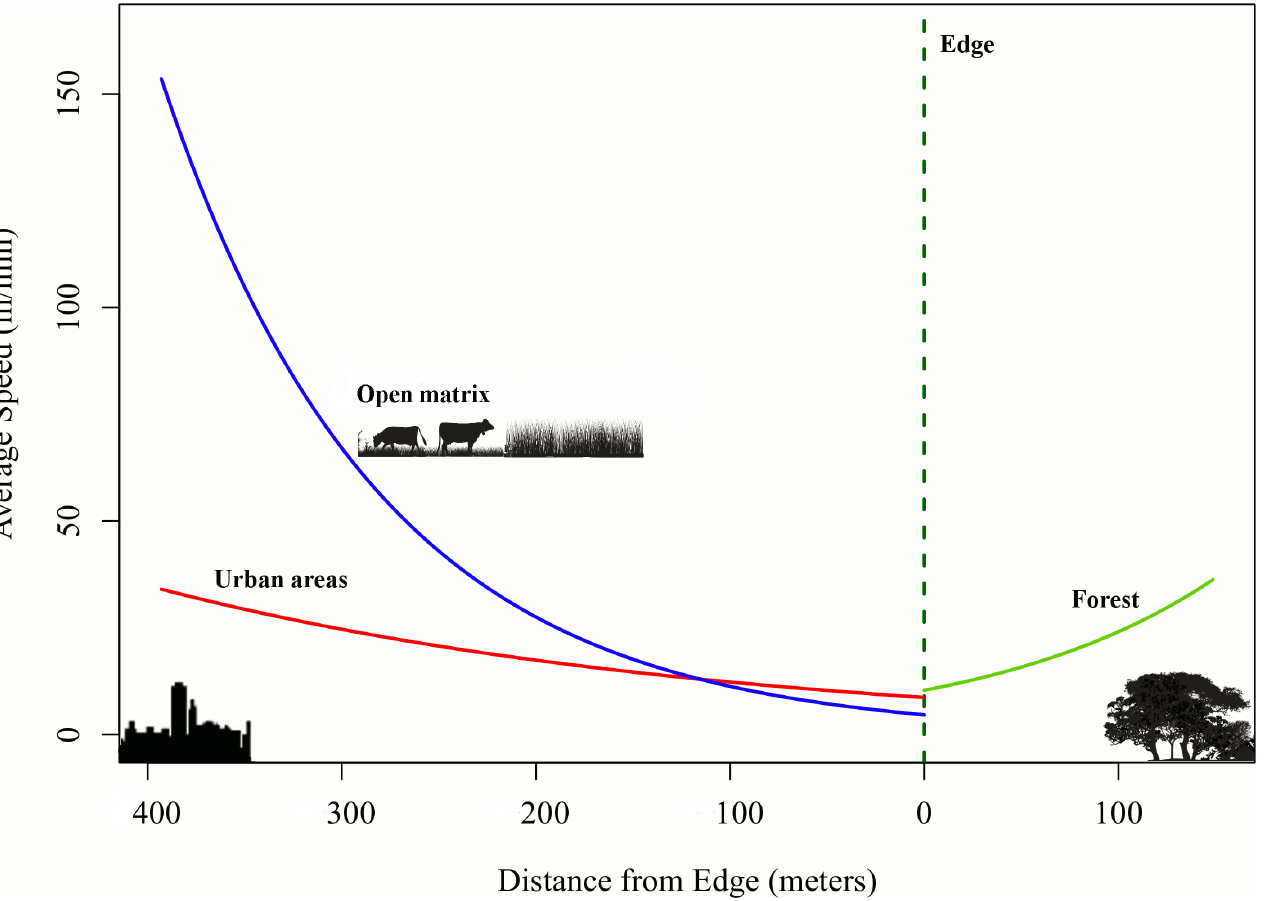
Fig 4. Average speeds of thrushes as a function of distances from edge, considering land cover classes. The dashed line represents the forest edges; green (forest), blue (open matrix — pastures and crops) and red (urban areas) lines represent the expected values for the mean speeds of individuals according to the exponential model M11, which considers the parameter settings being influenced by landscape variables (forest, open matrices and urban areas) and the forest edge distances. Speeds increase as individuals move away from forest edges.